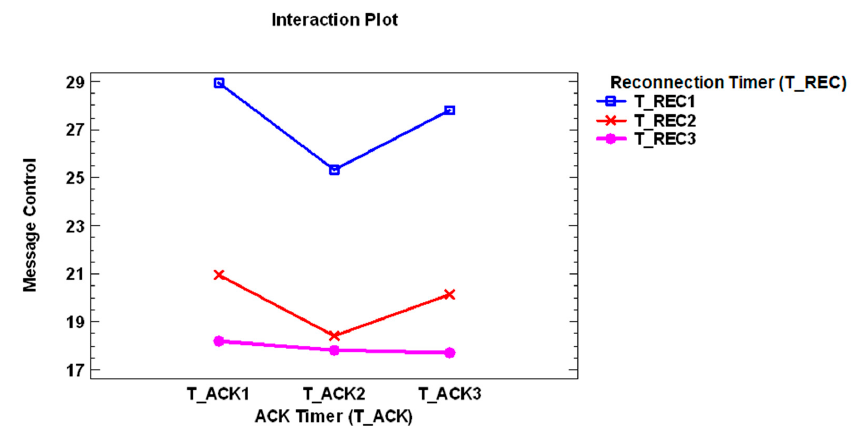
Figure 7. Evolution of the interaction between the main factor Reconnection Timer and ACK Timer, analyzing the dependent variable Number of control messages sent during the set-up time.